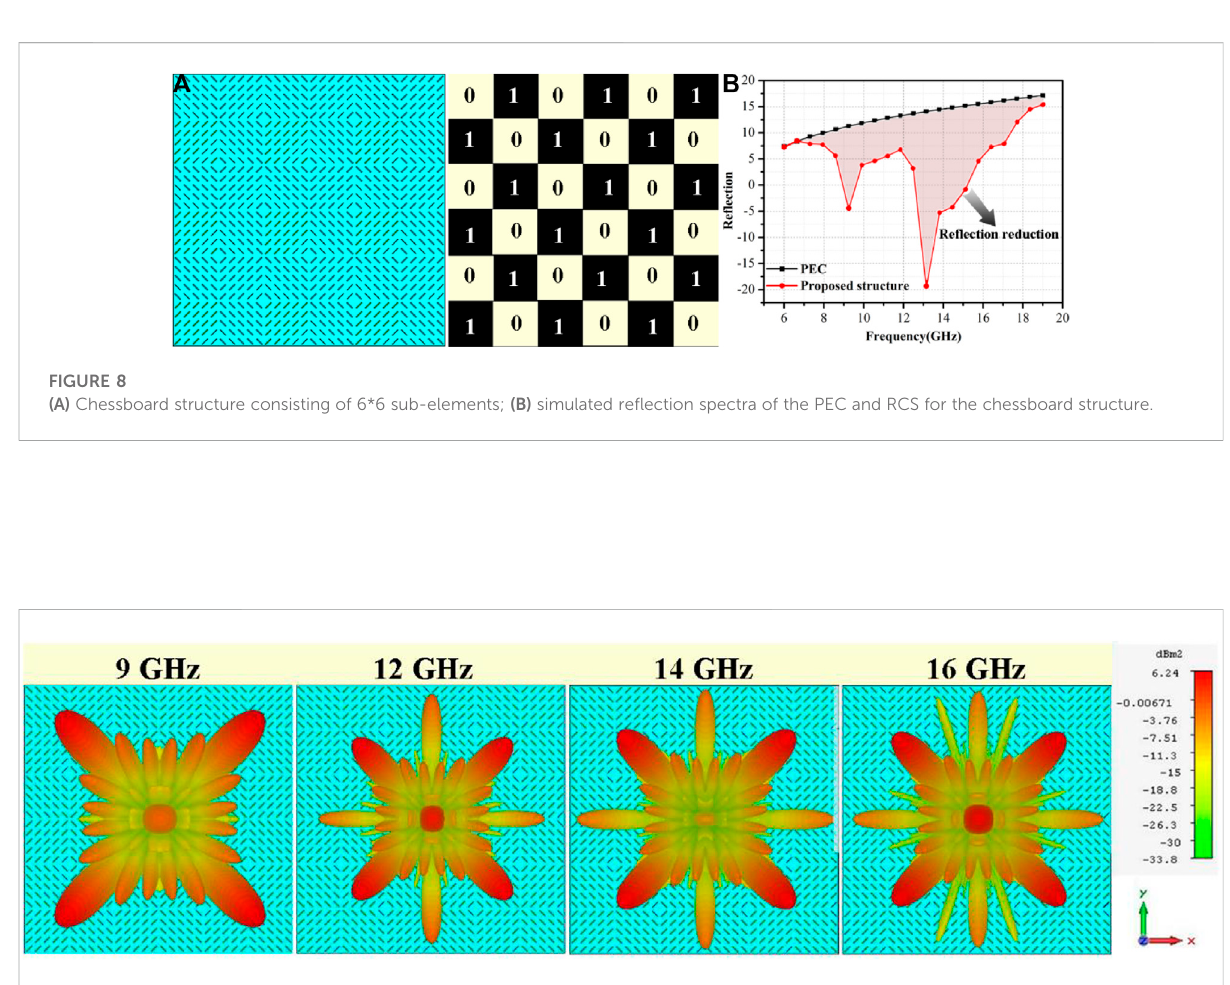
FIGURE 9 Three-dimensional scattering patterns of the chessboard